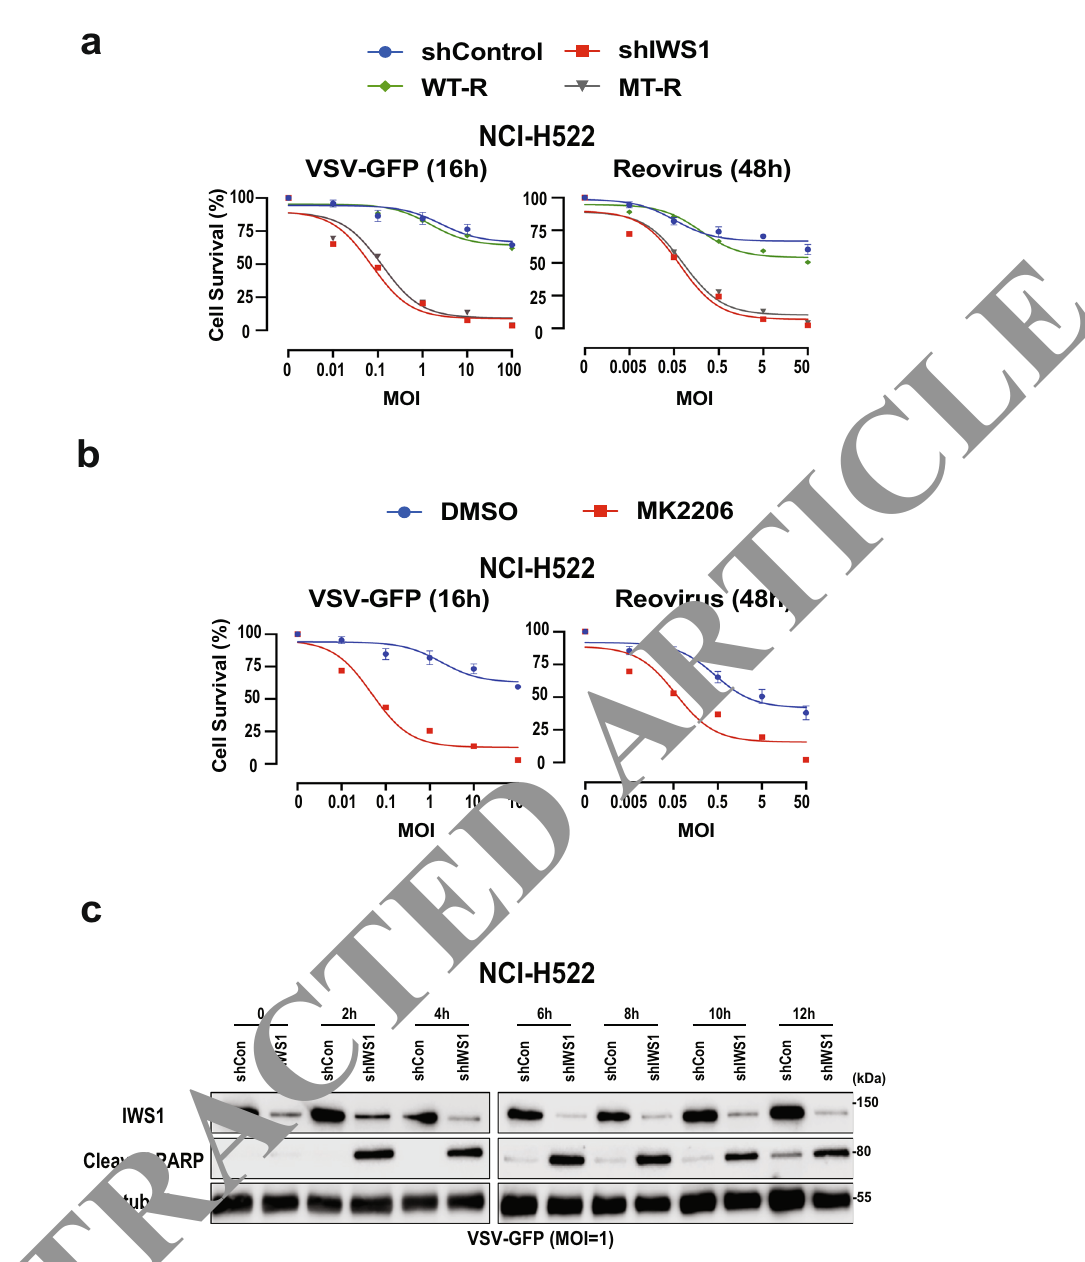
Fig. 7 Inhibition of the AKT/p-IWS1 axis sensitizes lung adenocarcinoma cells to virus-induced apoptotic cell death. a The knockdown of IWS1 and its rescue with the phosphorylation site IWS1 mutant sensitizes lung adenocarcinoma cell lines to virus-induced cell death . ShControl, shIWS1, shIWS1/WT-R and shIWS1/MT-R NCI-H522 cells were infected with VSV-GFP or Reovirus at the indicated MOIs. The percentage of surviving cells was measured 16 h later (for VSV-GFP) and 48 h later (for Reovirus), using the resazurin reduction protocol described in the methods section under “ virus-induced cell death ” . The cell survival curves show the mean percent survival values at each MOI ± SD ( n = 3) and they are representative of two independent experiments. b The inhibition of AKT, which is required for the phosphorylation of IWS1, sensitizes lung adenocarcinoma cells to virus-induced cell death . Parental NCI-H522 cells were treated with DMSO or with the AKT inhibitor MK2206 (5 μΜ ) and they were infected with VSV-GFP or Reovirus at the indicated MOIs. Infected and uninfected cells were harvested 16 h later (VSV-GFP), or 48 h later (Reovirus) and their survival was measured as in a. The cell survival curves show the mean percent survival values at each MOI ± SD ( n = 3) and they are representative of two independent experiments. c The knockdown of IWS1 accelerates the caspase-dependent cleavage of PARP1 in virus-infected lung adenocarcinoma cell lines . ShControl and shIWS1-transduced NCI-H522 cells were infected with VSV-GFP (MOI 1) and they were harvested at the indicated time points. Western blots of the harvested cell lysates were probed with antibodies to IWS1, cleaved PARP, or α